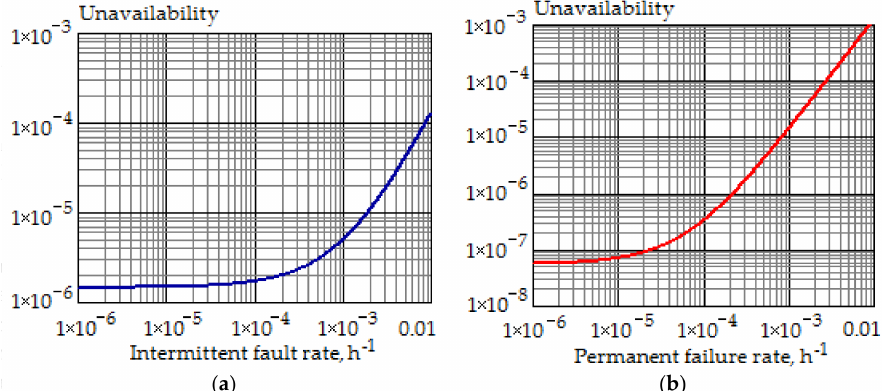
Figure 2. ( a ) Dependence of unavailability of the duplicated avionics system on the rate of intermittent faults when λ = 2 × 10 − 4 h − 1 ; ( b ) Dependence of unavailability of the duplicated avionics system on the rate of permanent failures when η = 2 × 10 − 4 h − 1 .